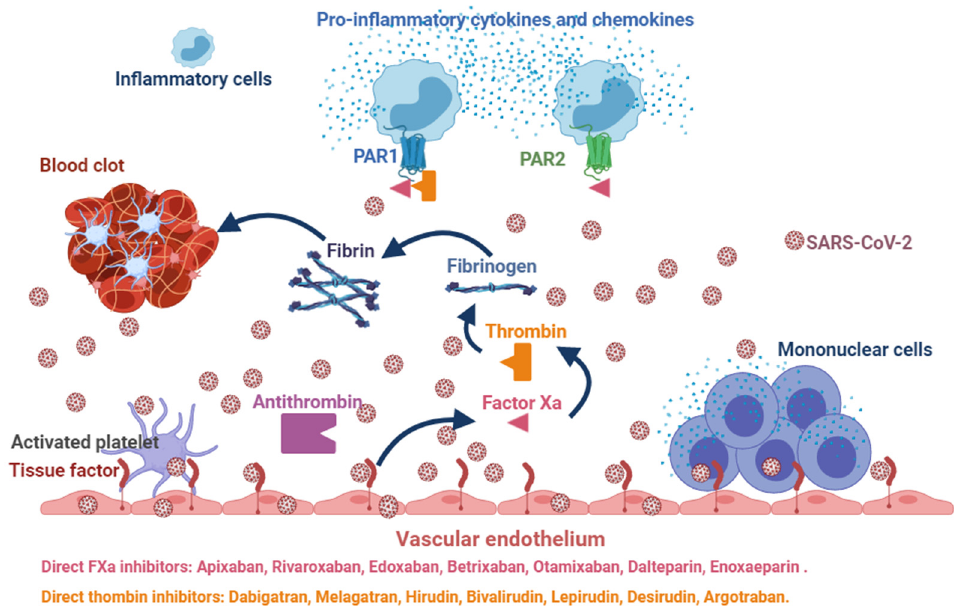
Figure 1. Interplay between SARS-CoV-2 infection, coagulation system, protease-activated receptors and inflammation. Activation of the coagulation cascade by the SARS-CoV-2 leads to the cleavage of fibrinogen into fibrin and platelet activation that can contribute to thrombosis. Platelet activation and fibrin degradation products can also enhance inflammation. Coagulation proteases can activate endothelial cells via protease-activated receptors that can increase the expression of inflammatory mediators. Drugs capable of inhibiting Factor Xa could attenuate the inflammatory response and modulate the coagulation cascade by reducing the formation of blood clots. This figure was created using the website https://app.biorender.com (accessed on 6 July 2021).